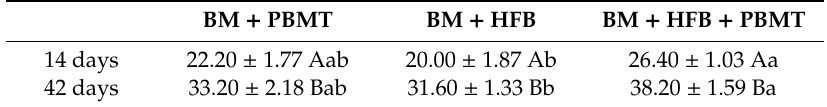
Table 1. Table of volume density of new bone formation